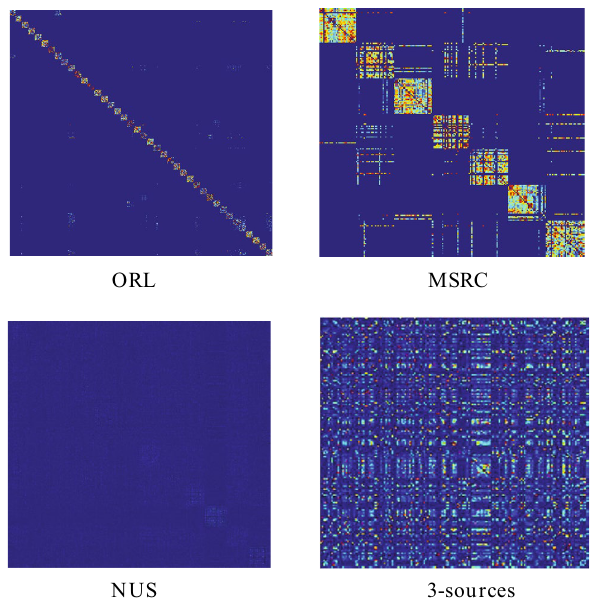
Figure 4. Visualize the unified matrix obtained by IMVSCP-1.